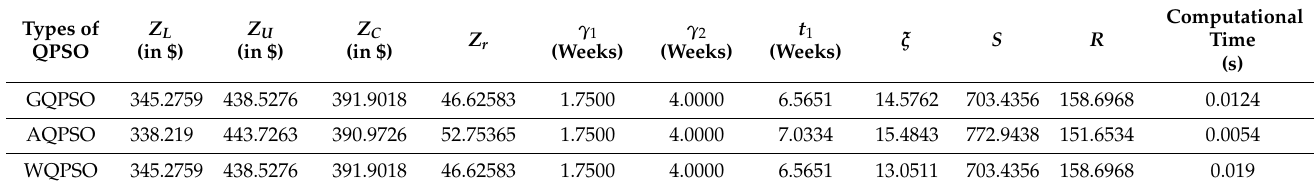
Table 9. Worst found results for Case- III of Example 3.